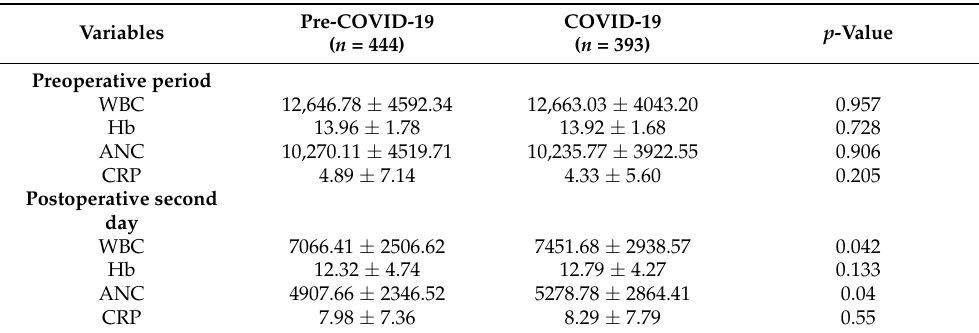
Table 3. Laboratory test results of the